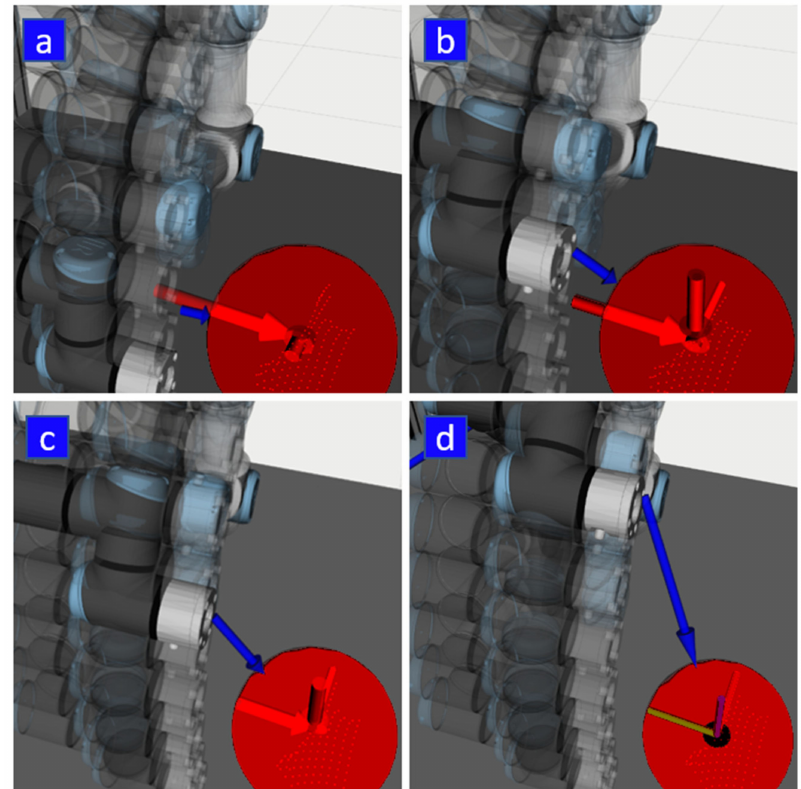
Figure 7. Visualisation of the vibration intensity of the tactors, lengths of the red vectors depict the intensity of vibration of right HMI tactors, which are dependent on the magnitude of the collision vector (blue arrow) and the relative orientation of the corresponding HMI. The robot is moving from the bottom ( a ) through intermediate position ( b ) to the upper position ( c ) until no vibration is provided ( d ) since the magnitude of the collision vector is higher than the reaction distance. The red sphere represents right HMI; red points represent HMI point cloud; HMI axes are shown by XYZ frame ( d